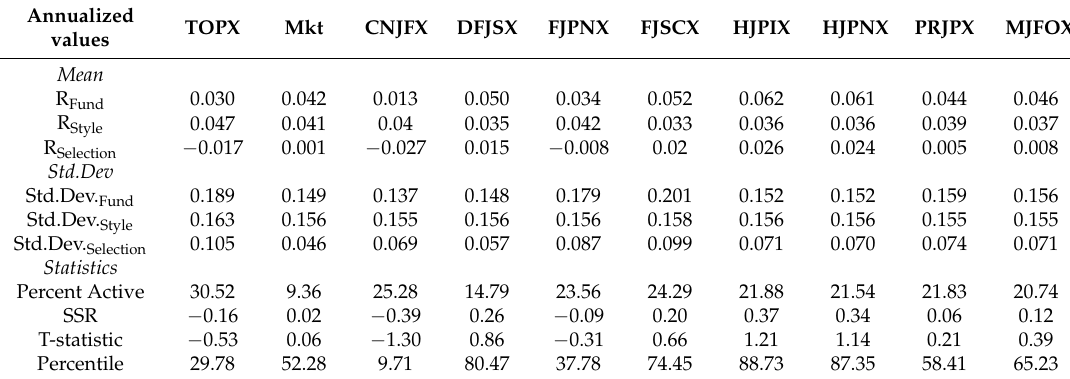
Table 6. Annualized values. SSR, Selection Sharpe